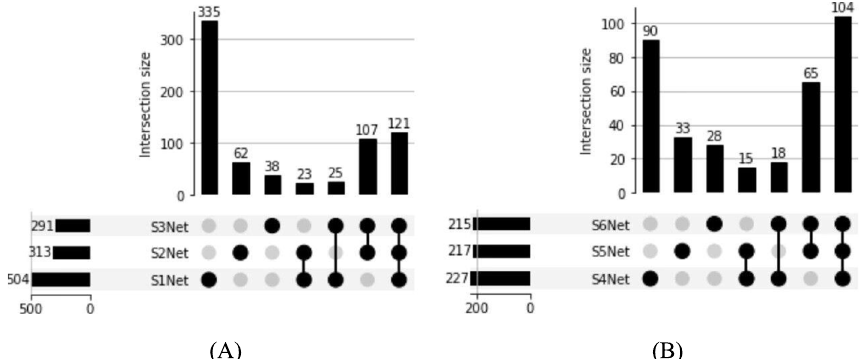
Fig. 2 Comparison of interaction information among different active networks. Note: A Three active networks S1Net, S2Net and S3Net in the inactive state of EET. B Three active networks S4Net, S5Net and S6Net in the activated state of